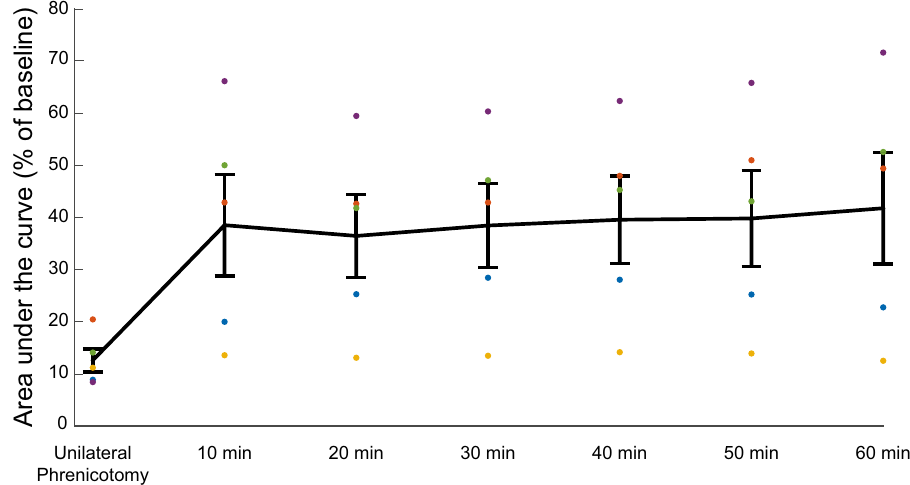
Figure 4. Light-induced diaphragm EMG activation is not attenuated over 1 hour of stimulation. Mice received a unilateral phrenicotomy and then closed loop photostimulation of the paralyzed hemi-diaphragm in phase with respiration using a 250 ms train of light pulses with inter-pulse interval of 0.1 ms and light pulse duration of 0.1 ms. Data are presented as a percent of baseline. Black line represents the mean + /− stdev. Individual scatter points represent each animal. After unilateral phrenicotomy there is a pronounced attenuation in EMG output. Photostimulation increases diaphragm EMG output of the paralyzed hemi-diaphragm. Ten-minute averages of evoked EMG activity show no attenuation of evoked bursts over a sixty-minute period of closed- loop, inspiratory triggered diaphragm photostimulation. Friedman Repeated Measures Analysis of Variance on Ranks showed a significant effect of time on evoked response ( p =